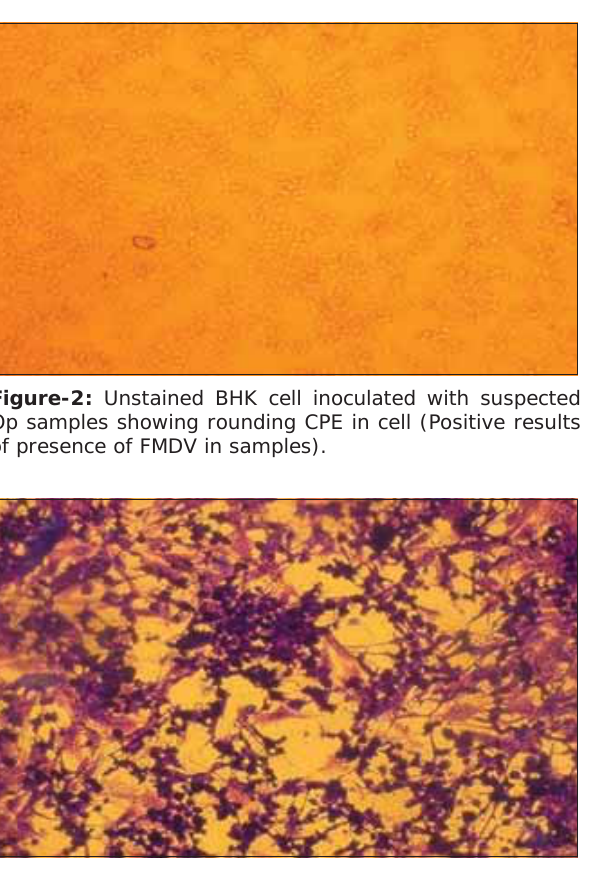
Figure-3: Stained BHK cell inoculated with suspected Op samples showing rounding CPE in cell (Positive results of presence of FMDV in